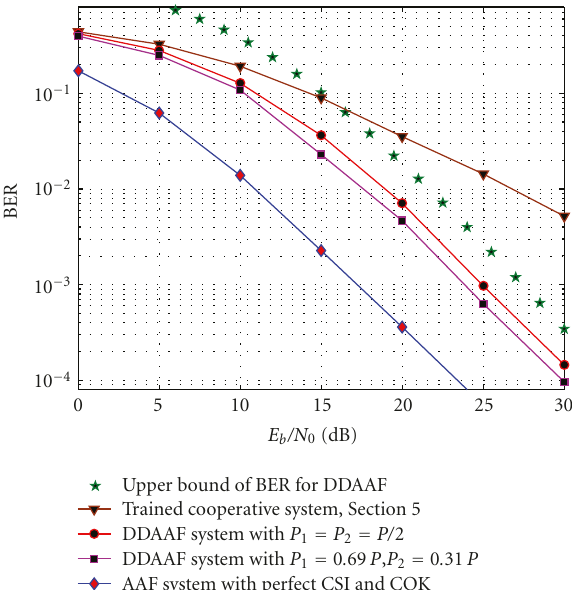
Figure 7: Comparison of DDAAF cooperative system with trained cooperative